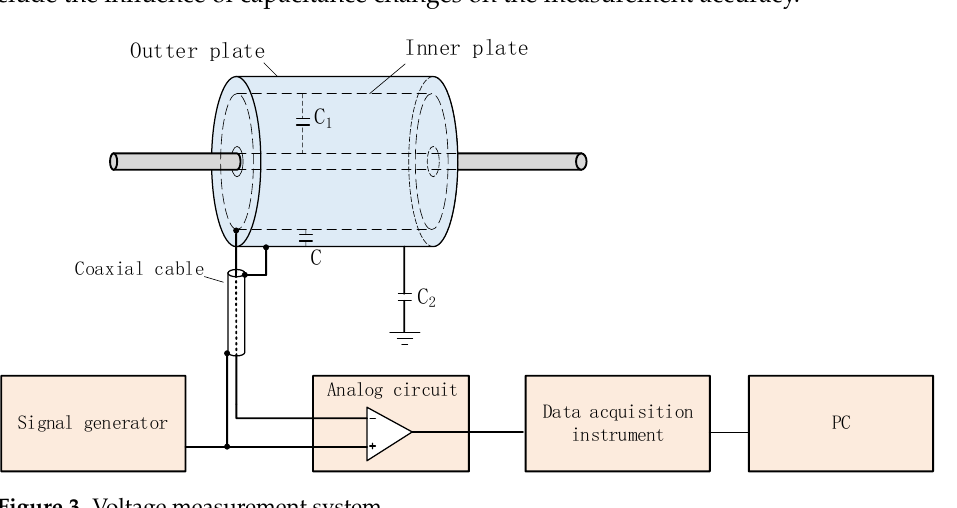
Figure 3. Voltage measurement system.